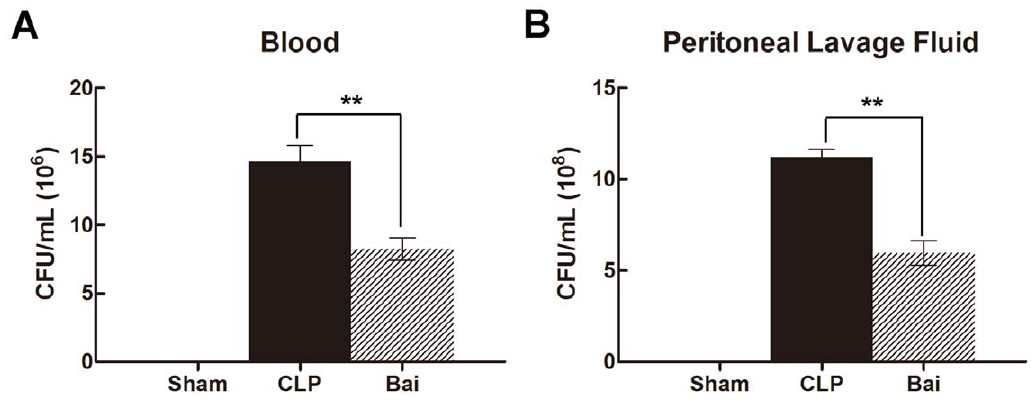
Figure 2. Bacterial clearance in blood (A) and peritoneum (B) in septic mice after baicalin treatment. Baicalin enhanced bacterial clearance in blood (A) and peritoneum (B). Blood and peritoneal lavage fluid were harvested 24 h after CLP. Bai, baicalin group; CLP, CLP group. Data analyses with one-way ANOVA and Newman-Keuls. ** P , 0.01.